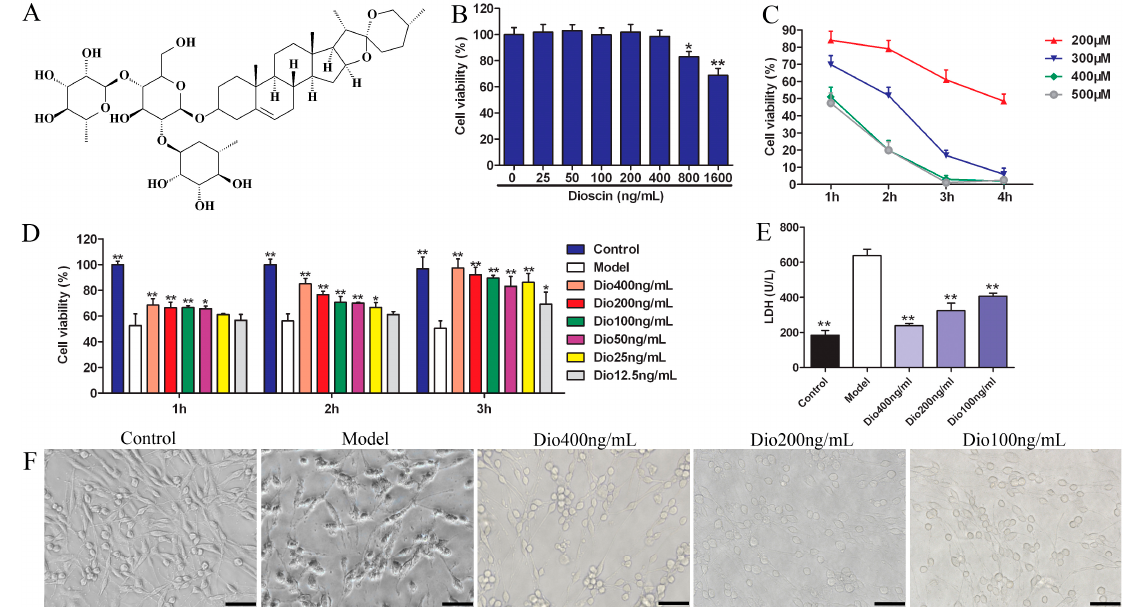
Figure 1. Protective effects of dioscin on H 2 O 2 -induced injury in PC12 cells. ( A ) The chemical structure of dioscin. ( B ) Cytotoxicity of dioscin on PC12 cells detected by MTT assay. ( C ) Effects of H 2 O 2 on cell viability. ( D ) Effects of dioscin alleviated on H 2 O 2 -induced cell injury. ( E ) Effects of dioscin on LDH release in H 2 O 2 -injured PC12 cells. ( F ) Effects of dioscin on the morphological changes of PC12 cells after H 2 O 2 treatment (400 × magnification; Scale bar = 50 µ M). Data are presented as the mean ± SD (n ≥ 5). * p < 0.05 and ** p < 0.01 compared with model